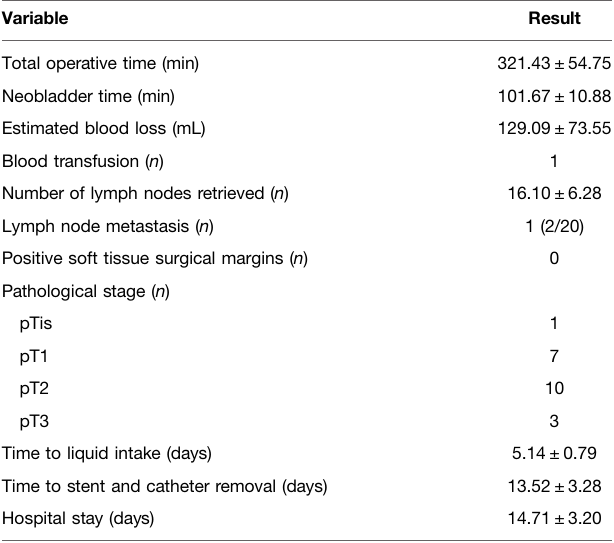
TABLE 2 | Perioperative characteristics.